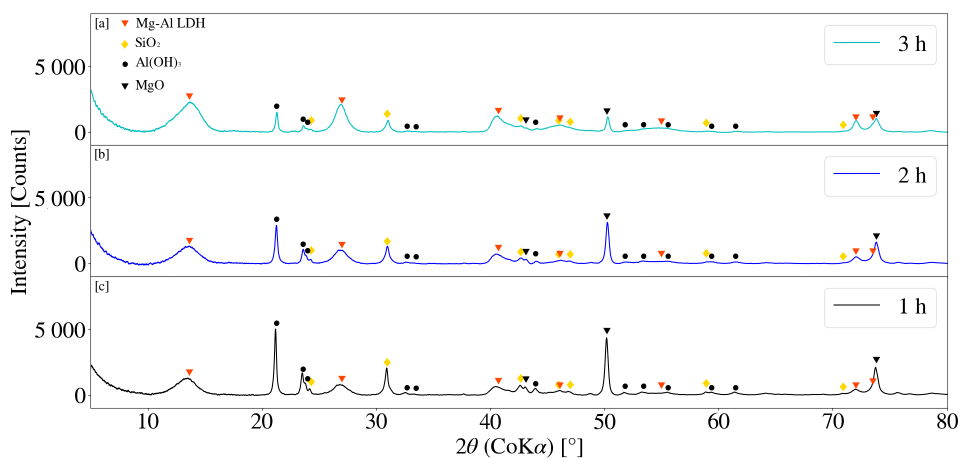
Figure 11. ( a ) X-ray diffraction pattern for Mg-Al LDH sample synthesised for a residence time of 3 h (S12). ( b ) X-ray diffraction pattern for Mg-Al LDH sample synthesised for a residence time of 2 h (S11). ( c ) X-ray diffraction pattern for Mg-Al LDH sample synthesised for a residence time of 1 h (S10). Milling parameters were set at a rotational speed of 2000 rpm, jacket water inlet temperature of 50 °C, media size of 2 mm and a solids loading of 10%.